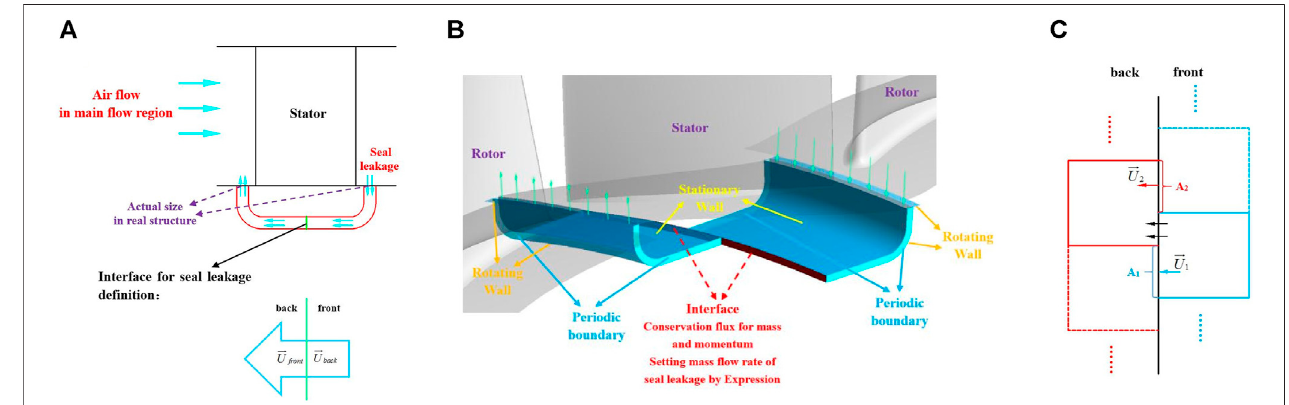
FIGURE1| MeridianandThree-dimensional fl owmodelofsealleakage.Meridian fl owmodelforsealleakageatstatorroot (A) ,Three-dimensionalsealleakage fl uid domain model (B) , Conservative fl ux transmissin method through the interface (C) .